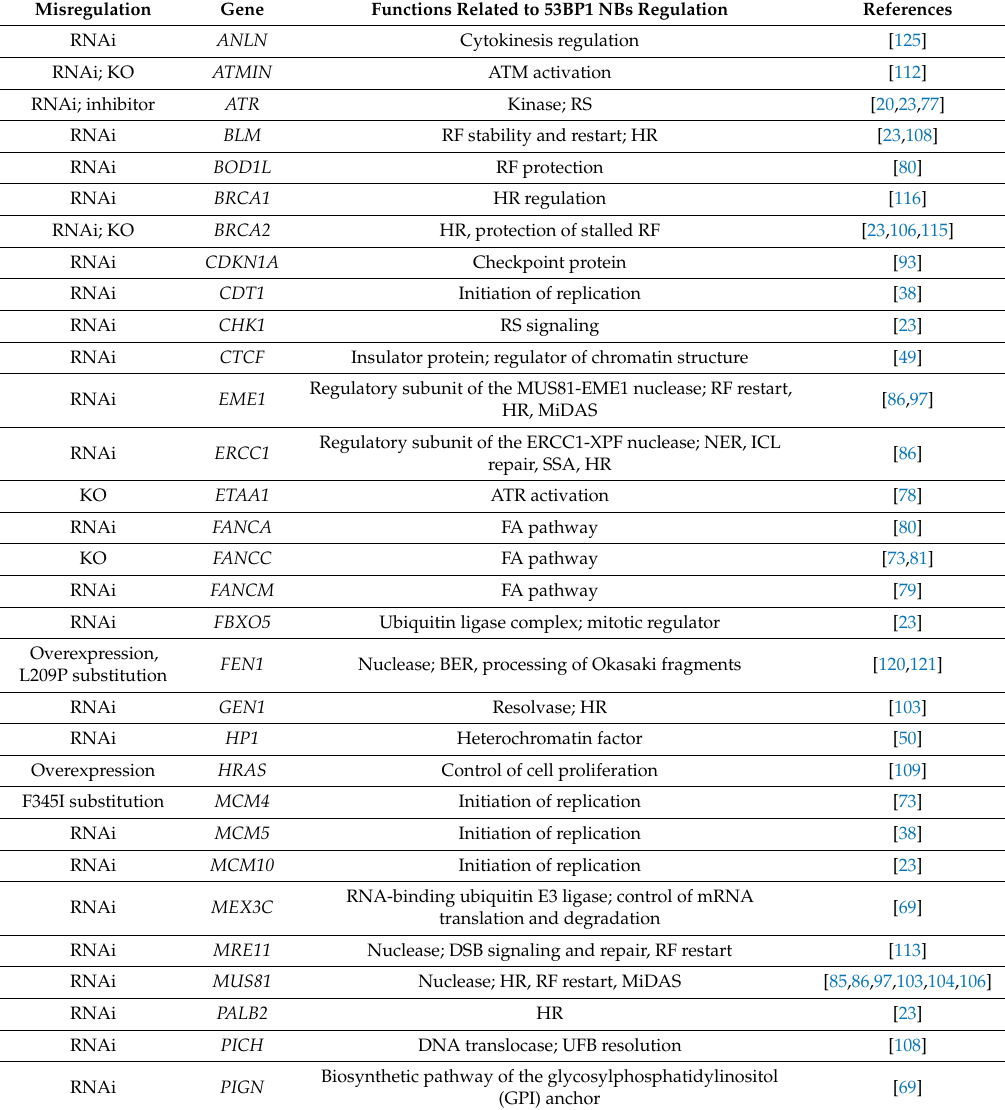
Table 1. Genes involved in increasing p53 binding protein 1 (53BP1) nuclear bodies (NBs) when misregulated.